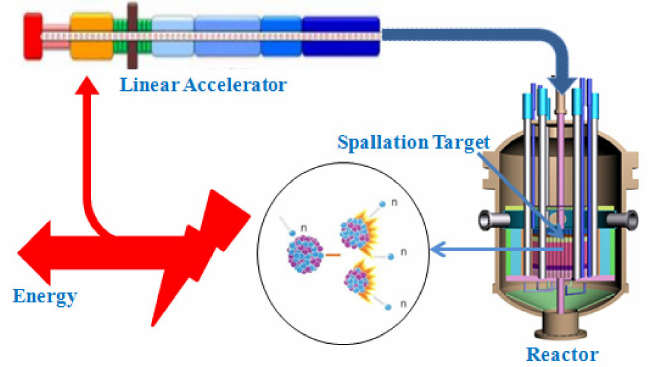
Figure 2. Schematic of the ADANES burner